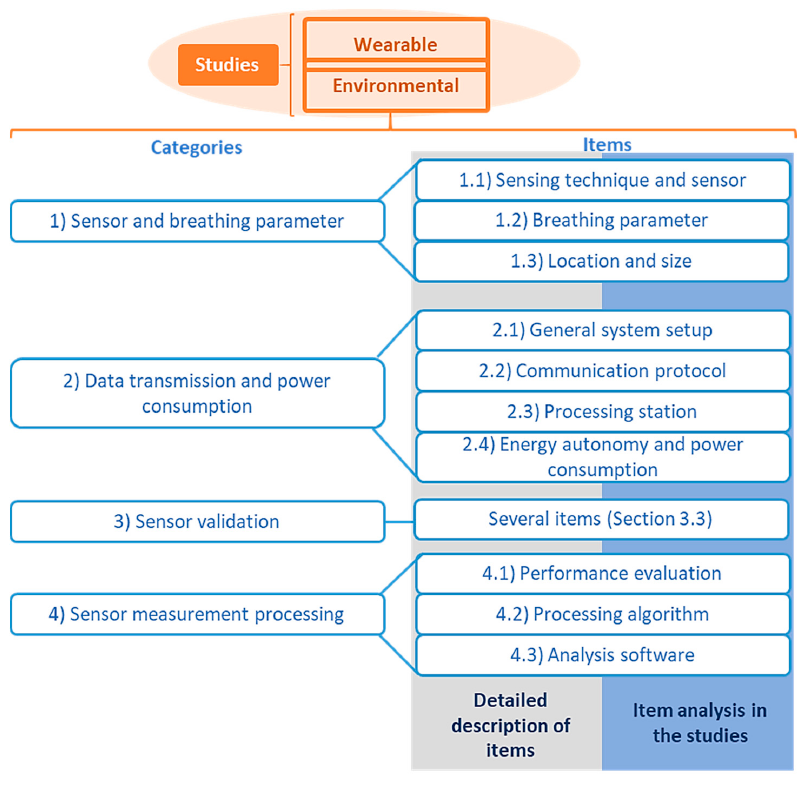
Figure 3. Analysis structure.